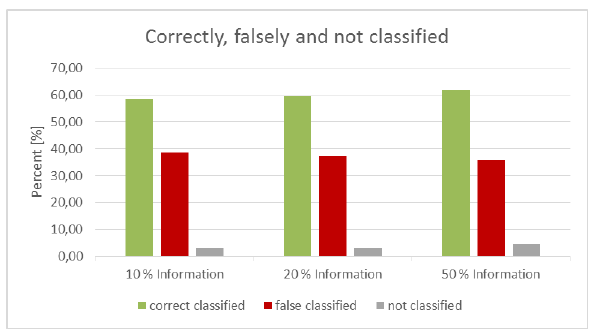
Figure 4. Classification of buildings for Ordinary Kriging